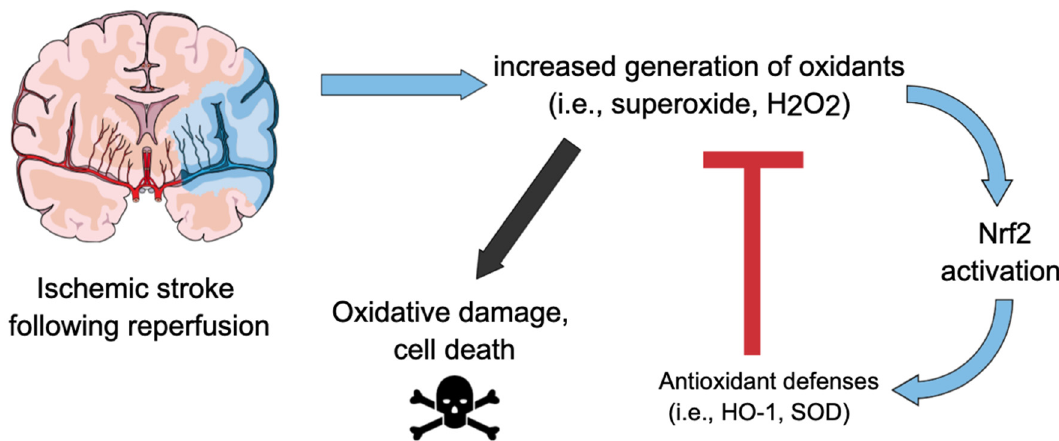
Figure 2. Interplay between ischemic stroke and Nrf2. Ischemia-reperfusion leads to increased levels of oxidants (i.e., hydrogen peroxide (H 2 O 2 ), superoxide anion (O 2 •− )) that, in turn, can activate Nrf2. Nrf2-downstream proteins (i.e., heme oxygenase-1 (HO-1), superoxide dismutase (SOD)) can mitigate the deleterious effects of oxidants produced in excess during IR, preventing oxidative stress and cell death.